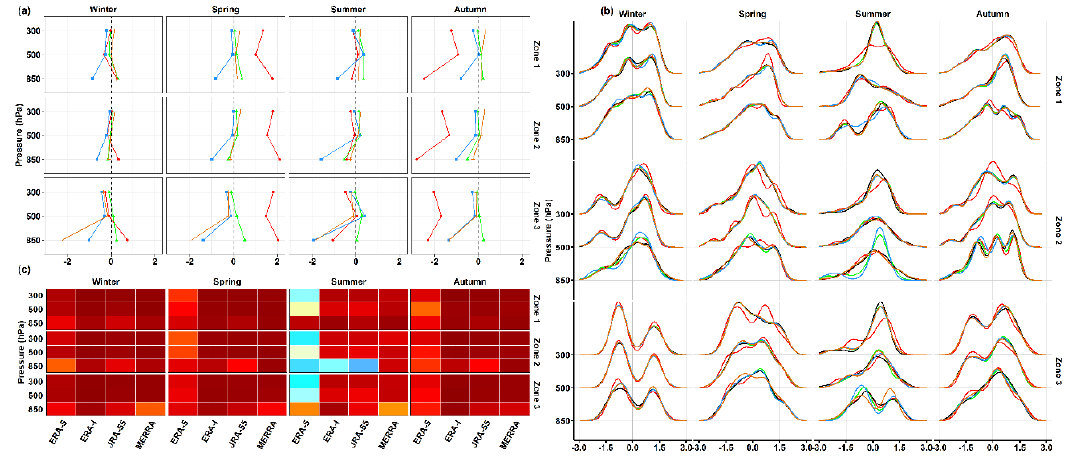
Figure 8. As in Figure 7, but for temperature (°C).